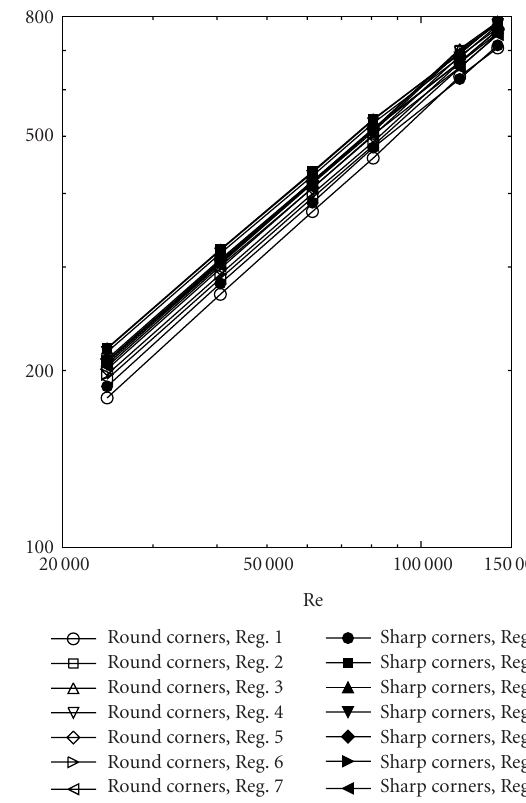
Figure 7: Comparison between the numerical results for sharp- and round-corner ribs with 15% blockage ratio ( e/D h = 0 . 15, P/e = 10).